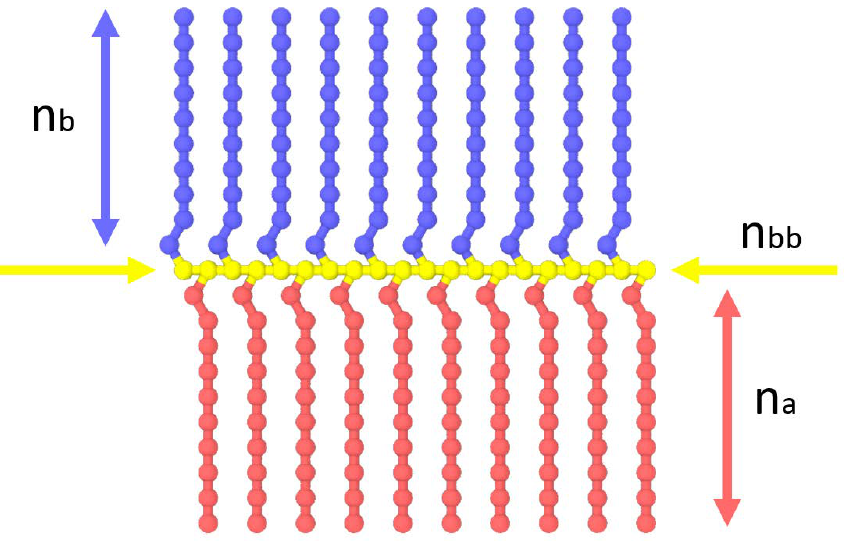
Figure 1. Schematic illustration of the studied amphiphilic bottlebrush copolymers with a homopoly- mer backbone (yellow) and alternating side chains composed of solvophilic A (red) and solvophobic B (blue) segments. For the current model, the fractions of A and B beads are equal ( f a = 0.5). Simulation Systems. The simulation systems include polymer beads as well as solvent beads of types W and O, which correspond to nominal amounts of water and oil, respec- tively. The liquids are chosen as being strongly incompatible with each other; a OW =